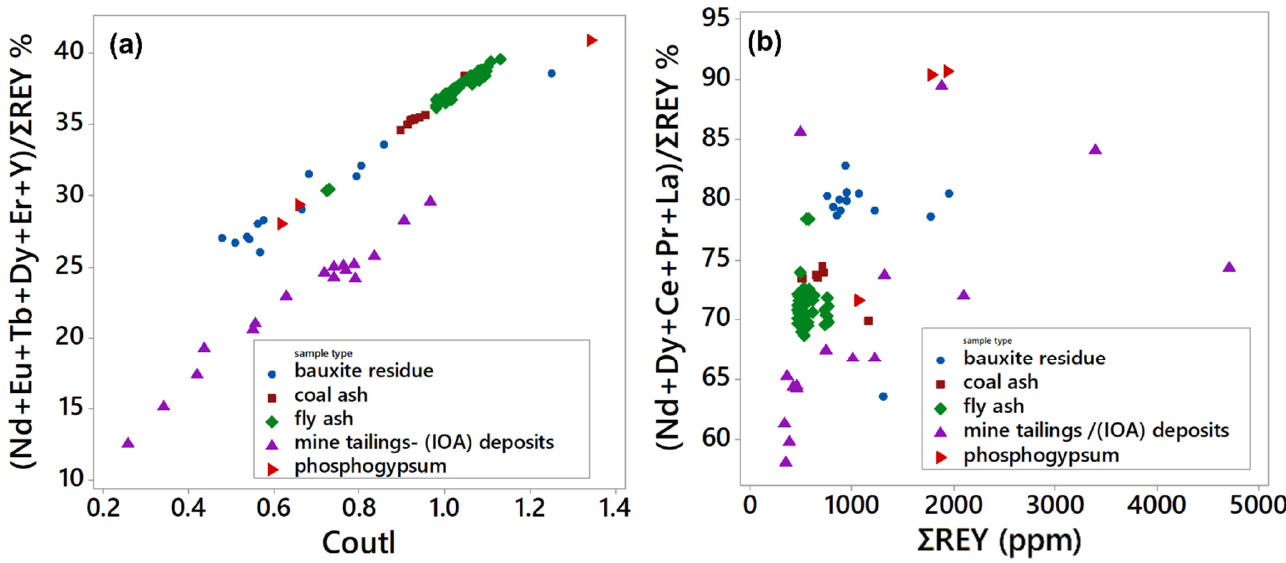
Figure 7. ( a ) Percentage of critical elements vs. Coutl for different types of solid mining waste with a total REO content > 1000 ppm. ( b ) Percentage of critical elements for the market of electromobility vs. Σ REY for different types of solid mining waste with a total REO content > 1000 ppm.